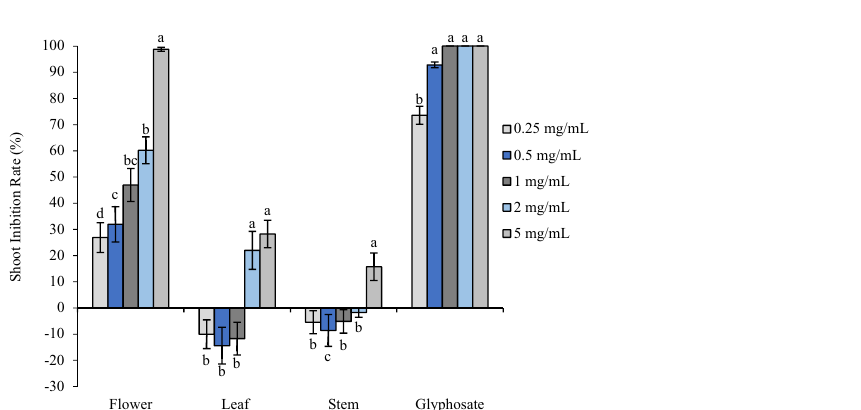
Figure 3. Phytotoxic effect of flower, leaf and stem oil of O. acanthium as well as glyphosate on radical elongation of P. annua . Each value is the mean of three replicates ± SE ( n = 30). Significant difference ( p < 0.05) was represented by different letters.